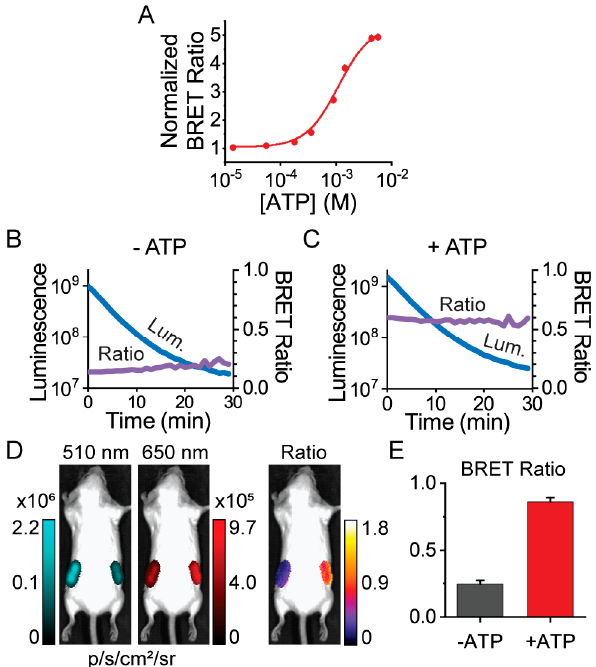
Figure 4. Ratiometric BRET imaging of ARSeNL purified protein using the Spectral Instruments (SI) Ami HT whole-animal imaging system. ( A ) The dynamic range is not a ff ected by the use of standard GFP (510 / 20 nm) and RFP (650 / 20 nm) emission filters in the SI Ami HT imaging system (K D = 1.1 ± 0.2 mM, n = 3). Data were fitted to the Hill equation. ( B , C ) The mScarlet / NanoLuc BRET ratio (purple) is stable over time in solutions containing 0 mM ATP ( B ) or 10 mM ATP ( C ) and 1 nM ARSeNL protein ( n = 4), while the total luminescence intensity (blue) decays. ( D , E ) Whole-animal imaging of unshaved adult Balb / c mice. ARSeNL, pre-equilibrated with or without ATP, was placed subcutaneously in the left and right hindlimb areas, respectively, and the ATP-dependent ratio di ff erence was preserved when imaged through tissue and fur (mean ± sd, n = 3, p < 0.001).